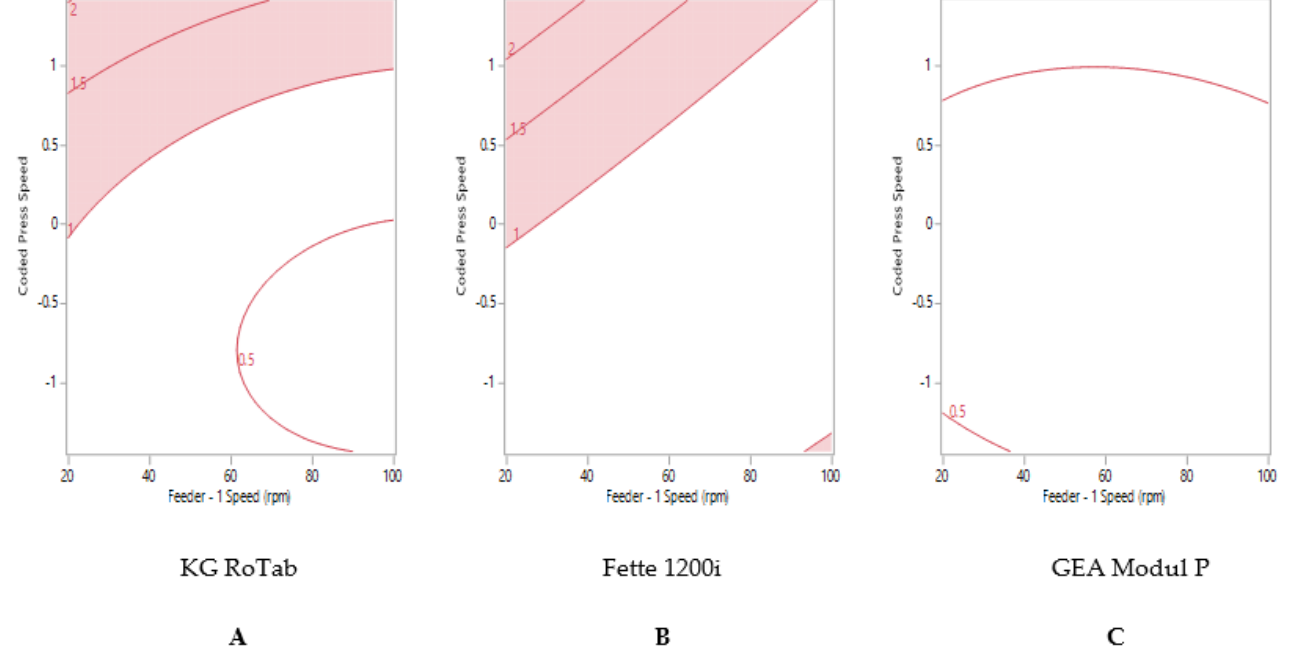
Figure 2. Two-dimensional contour profile showing optimum tablet press speed and feeder speed settings (uncoloured) for formulation 1 “good flow” to achieve tablet weight variability ≤ 1% RSD on ( A ) KG RoTab, ( B ) Fette 1200i and ( C ) Modul P. Coded press speeds refer to standardized press speed for each tablet press by subtracting the mean press speed from the actual press speed and dividing by the standard deviation. Refer to supplementary information (Table S4) for the actual press speeds.